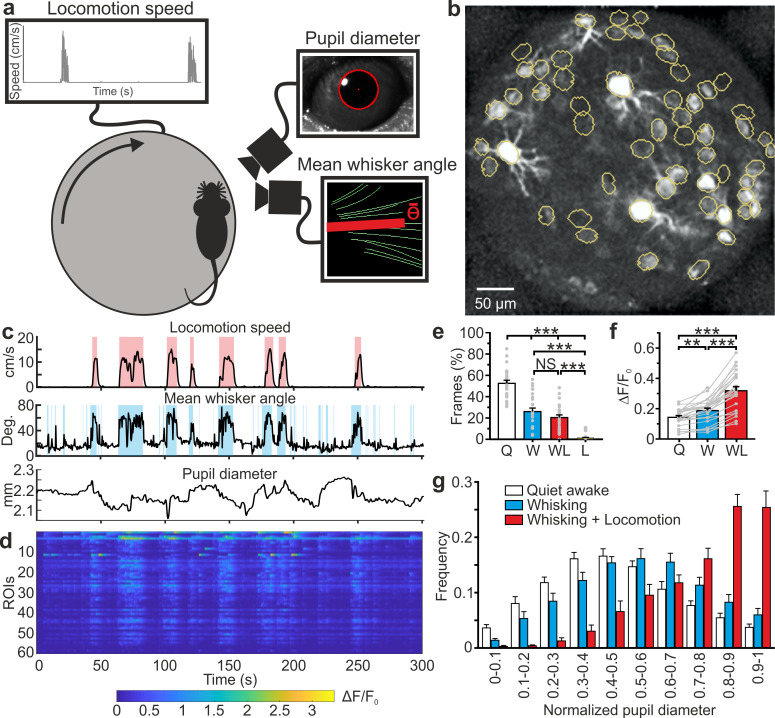
High-resolution population dynamics in the VPM of awake mice during locomotion and free whisking.(a) Schematic of the experimental set-up for the recording of locomotion, whisker mean angle, and pupil size in awake head-fixed mice during VPM imaging using type II eFOV-microendoscopes. (b) Two-photon image of GCaMP6s labeled VPM neurons in vivo. (c) Representative traces of locomotion (top), whisker mean angle (middle), and pupil diameter (bottom). Red and blue shades indicate periods of locomotion and whishing, respectively (see Materials and methods for definition). (d), ΔF/F0 over time for all different ROIs in the experiment shown in (c). (e) Percentage of frames spent by the animal in quite wakefulness (Q), whisking (W), locomotion (L), and whisking + locomotion (WL). n = 24 time series from four animals. One-way ANOVA with Bonferroni post-hoc correction, p=3E-23. (f) Average ΔF/F0 across ROIs under the different experimental conditions. n = 24 time series from four animals. One-way ANOVA with Bonferroni post-hoc correction, p=2E-16. (g) Distribution of the Q, W, and WL states as a function of pupil diameter. Kolmogorov-Smirnov test for comparison of distributions of Q, W and WL states: p=0.07 for Q vs. W states, p=2E-10 for Q vs. WL states, p=1E-5 for W vs. WL states. For the statistical comparison of Q, W and WL states in each range of pupil diameter a two-way ANOVA with Tukey-Kramer post-hoc correction was performed; see Supplementary file 1 - Table 4. The error bars represent s.e.m across different t-series.Figure 6—source data 1.Percentage of frames, ΔF/F0, and distribution of pupil diameter across behavioral states.